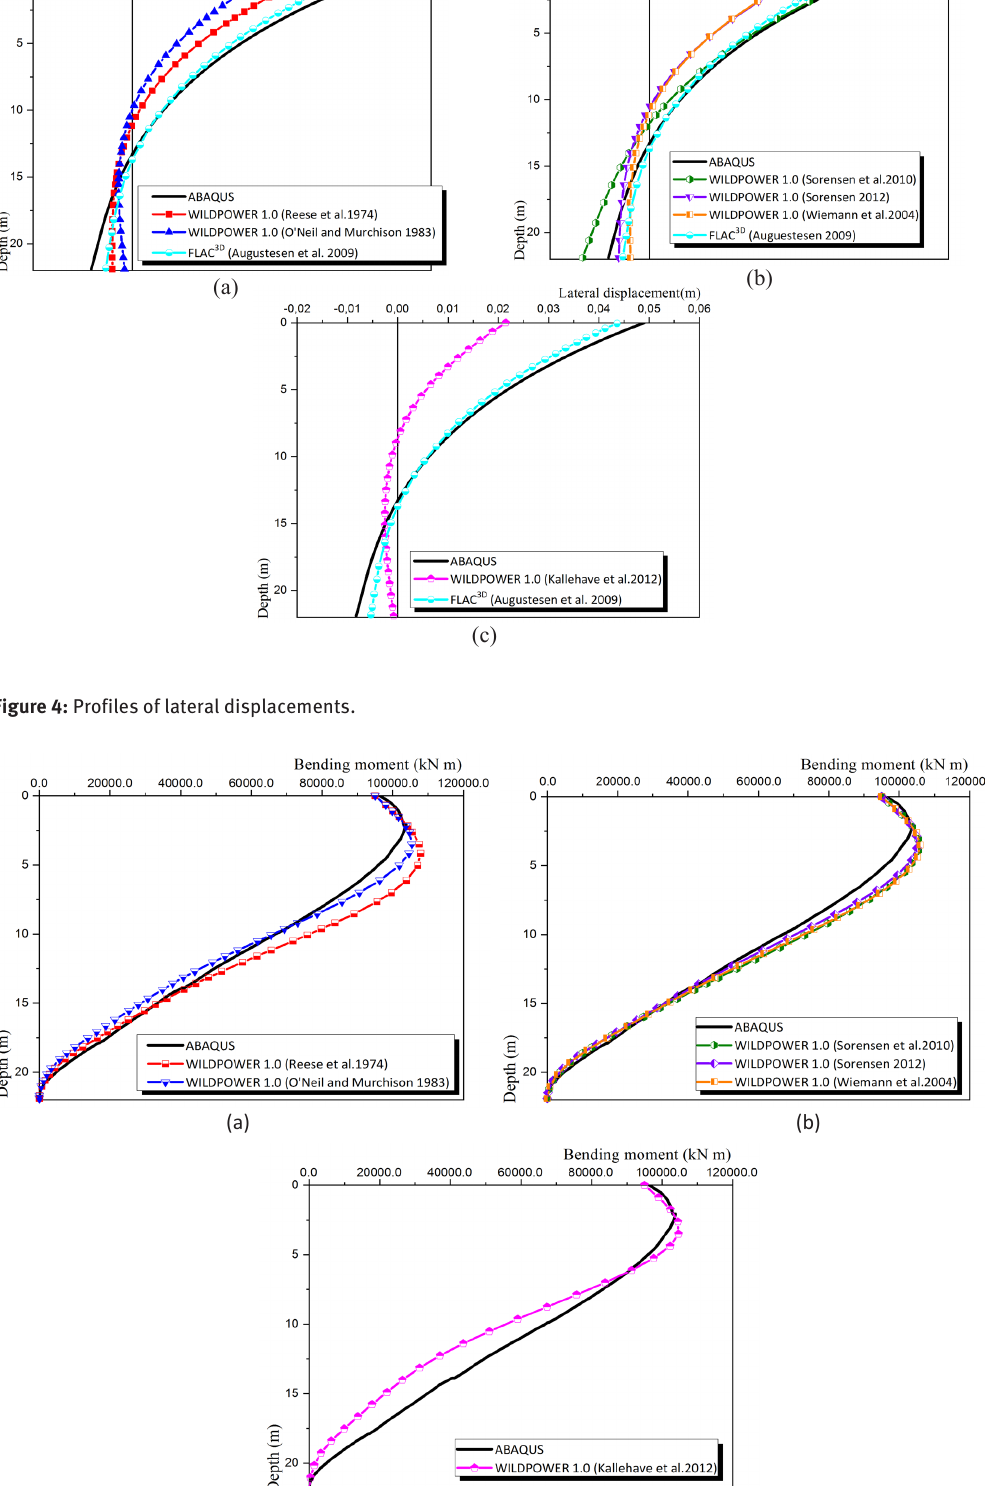
Figure 5: Profiles of bending